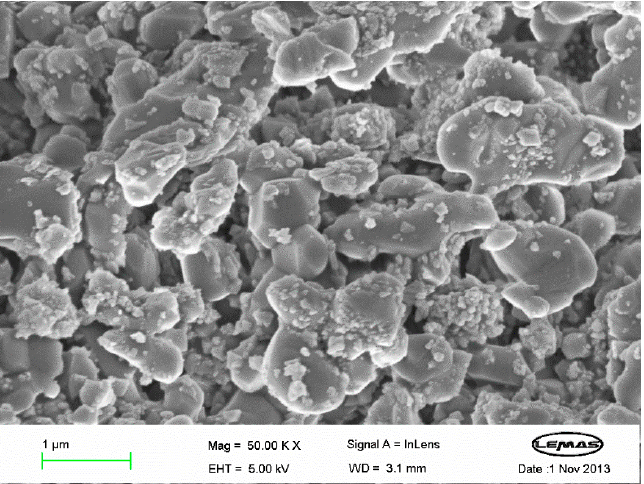
Figure 6. SEM image of the NiO/Al 2 O 3 used in this work.